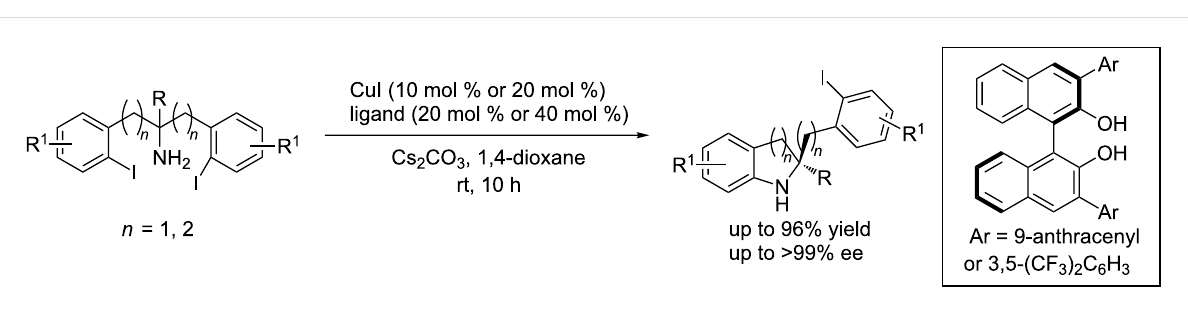
Scheme 16: Asymmetric aryl C–N coupling reactions following a desymmetrization